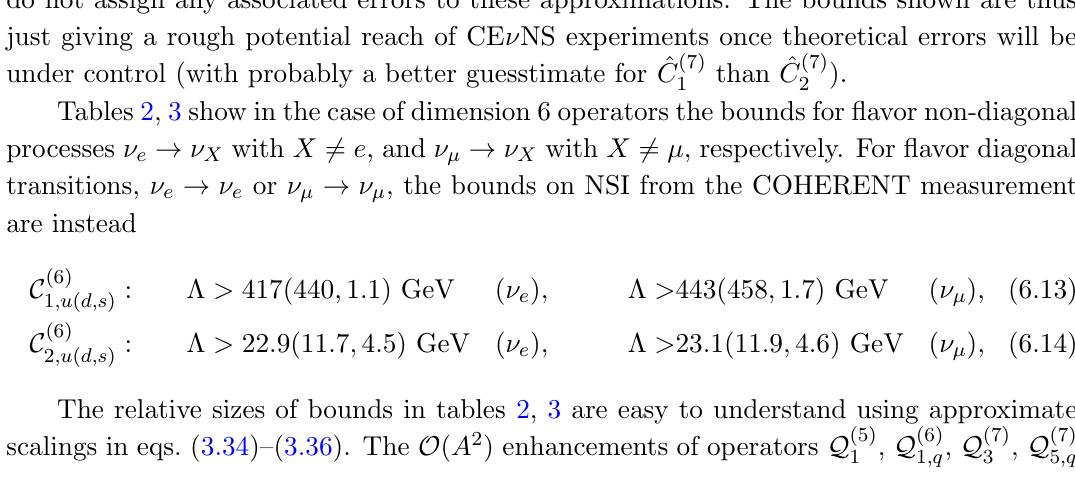
Table 2 . The 90 % C.L. lower bounds on (cid:3) from COHERENT, CHARM, and NaI 2T for (cid:23) e ( X = e , for X = e see main text) NSI Wilson coe(cid:14)cients, ^ 6 and assuming only one such NSI Wilson coe(cid:14)cient is nonzero. For ^ C (7) central value of the form factor (NDA estimates) so the bounds are merely indicative, see main text for